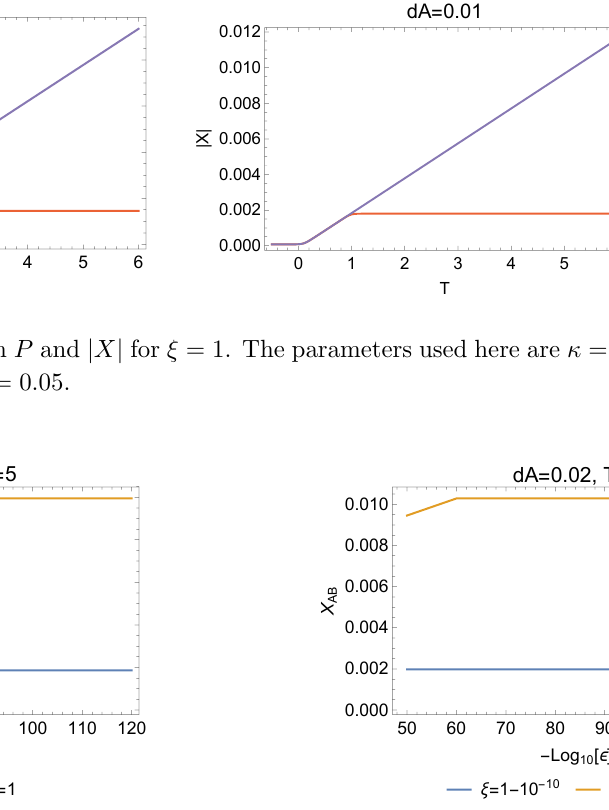
Figure 8 . Convergence of P and j X j in (cid:15) . Shown here are the plots of P and j X j of eqs. (1.4) and (1.3) against log (cid:15) , where (cid:15) is the uv-regulator appearing in the Wightman function (see 10 eq. (B.1)). The parameters settings are T = 5 and d A = 0 : 02, corresponding to an intermediate point in the center (cid:12)gure of (cid:12)gure 2. Both the P and j X j terms clearly converge for small (cid:15) .